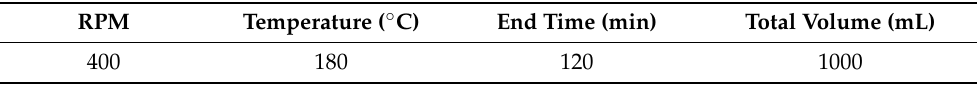
Figure 6. BEM sample fabrication process: ( a ) BEM mix status; ( b ) mix complete BEM. Table 4. Detail of fabrication process for mix BEM.